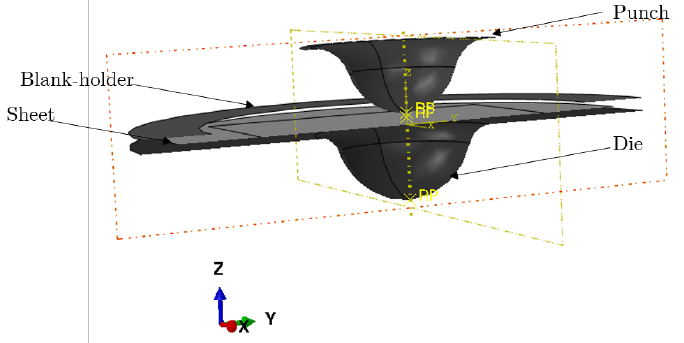
Figure 9. FE model—deep drawing.